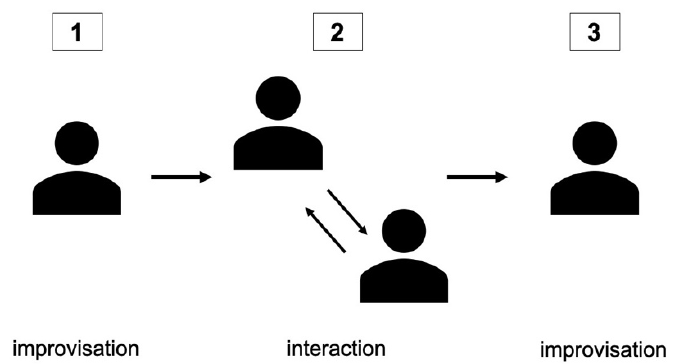
Figure 2. Stages in experiment 1. Participants take part in 3 stages: first, they take part in an improvisation stage, producing gestures to describe each vignette. They then take part in an interaction stage, producing and interpreting gestures in interaction with a partner. Finally, they complete a second improvisation stage.